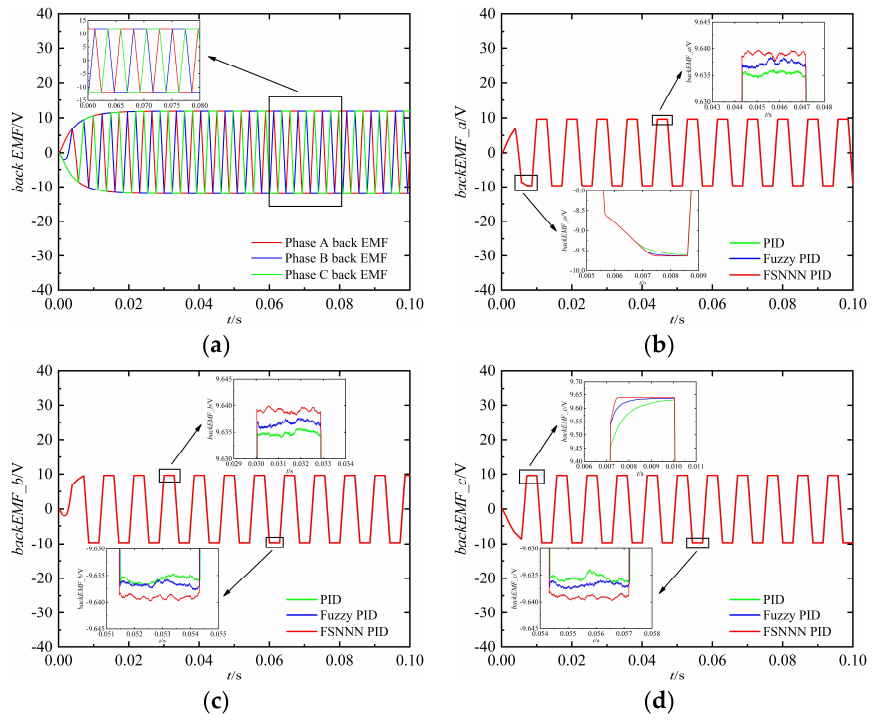
Figure 17. Back EMF curves at 7000 r/min under different algorithms. ( a ) Three-phase back EMF curves under no-load open loop control; ( b ) phase A back EMF; ( c ) phase B back EMF; ( d ) phase C back EMF.